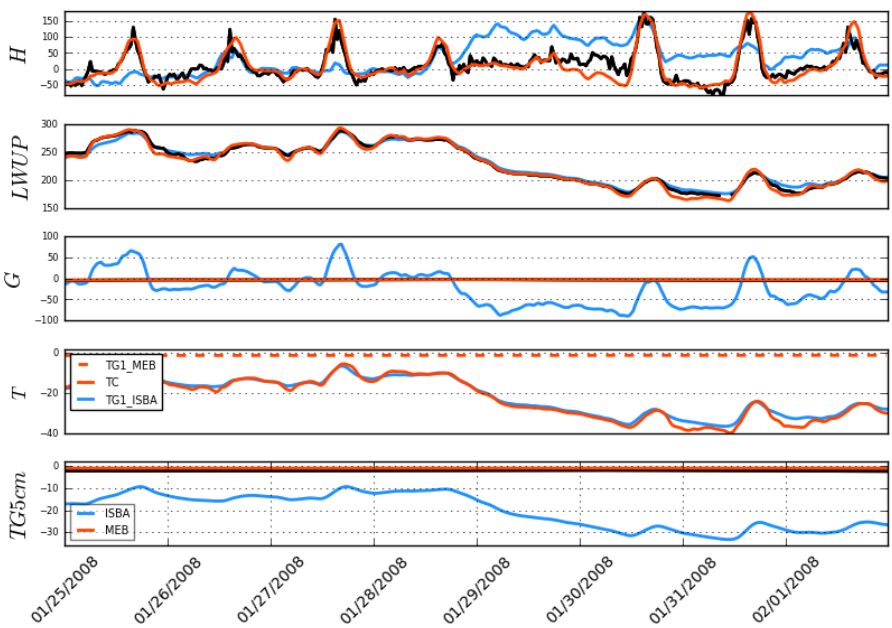
Figure 8. Multiple variables at the OJP site from 25 January to 1 February 2008. MEB is in red, ISBA is in blue, and observations are in black. For T , the red curve is T C (MEB), the dotted red curve is T G 1 (MEB), and the blue curve is T G 1 (ISBA).